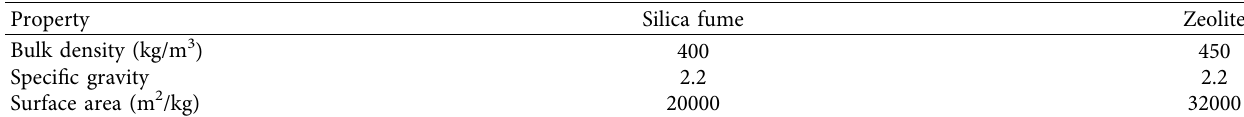
Table 3: Physical properties of silica fume and